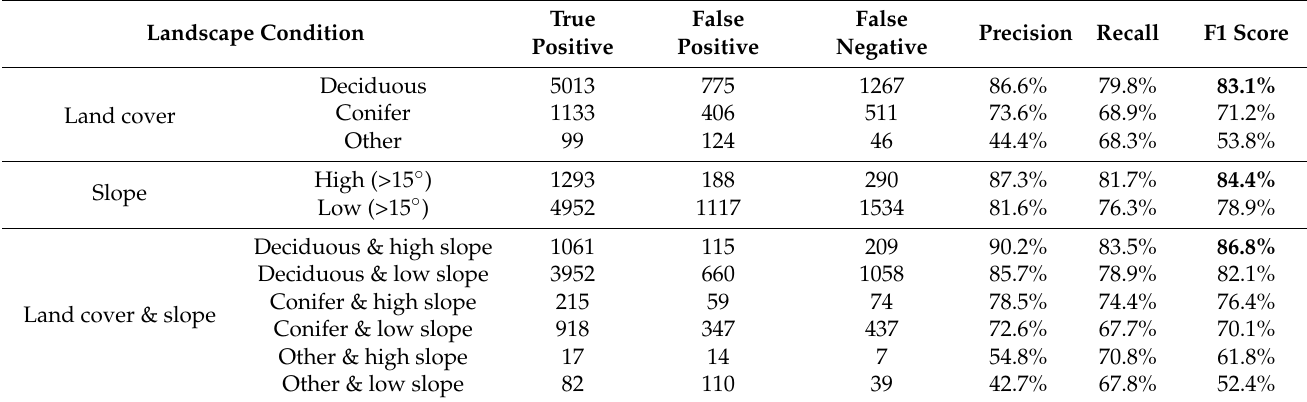
Table 6. Accuracy assessment results (true positive, false positive, false negative, precision, recall, and F1 scores) of the S2 model in five towns in terms of RCH condition (i.e., land cover type, slope degrees, and their combination). Bold text represents the highest F1 score in each landscape condition category.